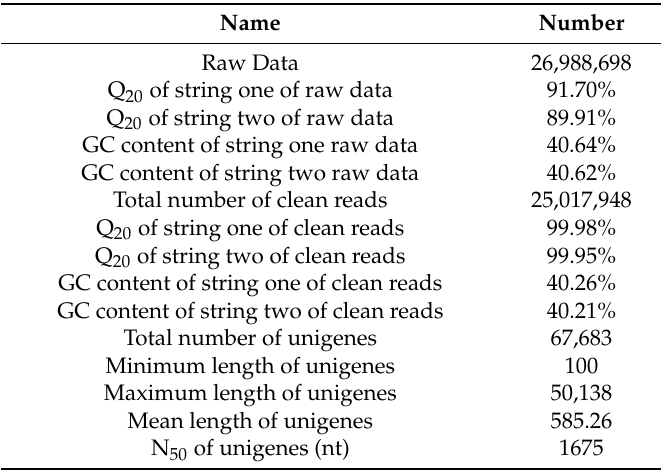
Table 1. Summary of Ctenochauliodes similis